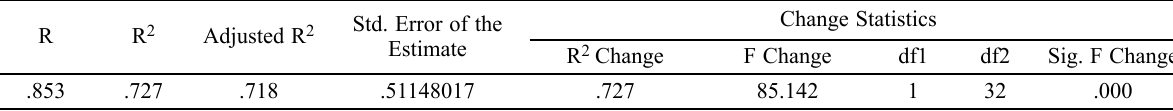
Table 9. ANOVA for the Enablers and Results excellence factors R R